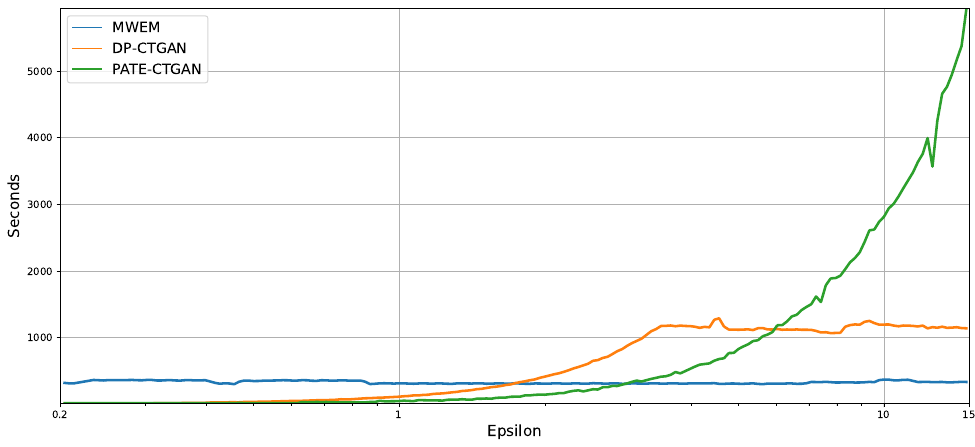
Figure 7. Runtime measurements for MWEM, DP-CTGAN and